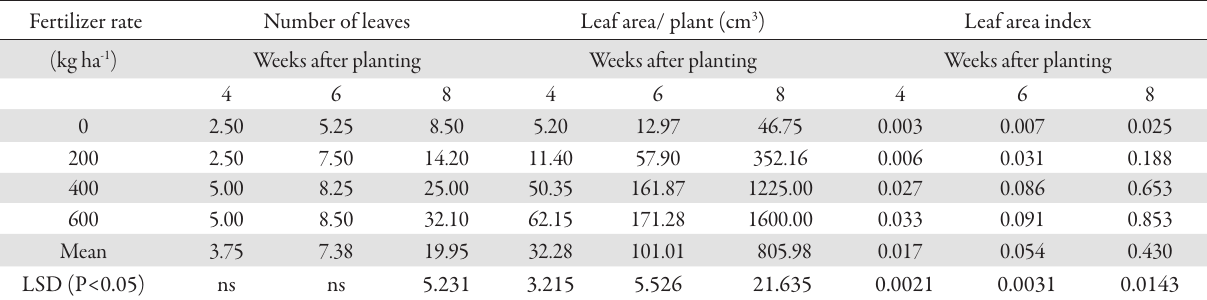
Tab. 2. Effects of NPK 15:15:15 fertilizer application on the growth of maize ( Zea mays ) Fertilizer